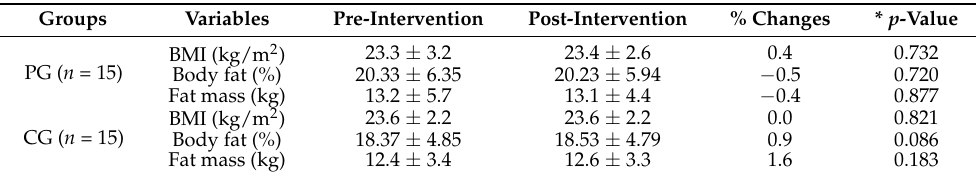
Table 2. Body mass index, body fat percentage and fat mass of PG and CG before and after 6-weeks of